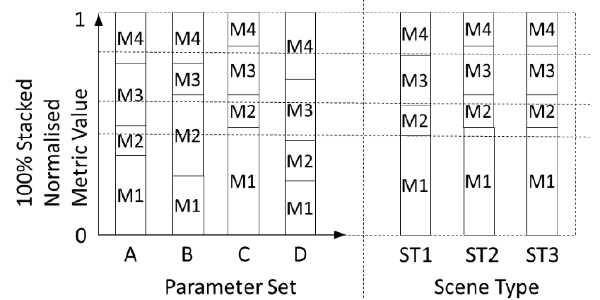
Figure 8 Example of finding the optimal parameter set for a scene type. Here the parameter set C has the metrics that best correspond to scene ST1. Therefore if a scene is of type ST1, for this algorithm the parameter set C is the optimal choice. One final problem remains, and this is to quantify and rank parameter sets and segmentation algorithms for given scene types. The concept behind the proposed ranking is shown in Figure 9. The absolute difference of corresponding metric values for the reference scene and a parameter set are summed.